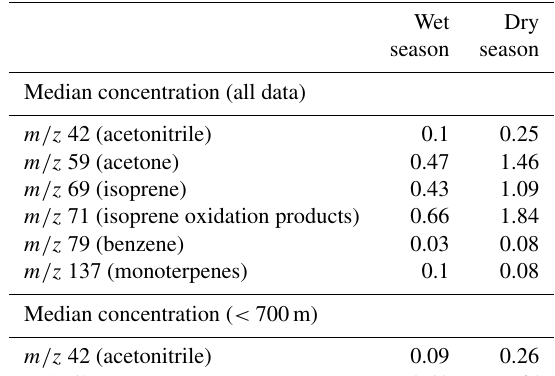
Table 3. Measurements of VOC species made by the PTR-MS on board the G-1. Units are ppbv. The statistics for altitudes less than 700m approximate the boundary layer conditions at the time of the flights.